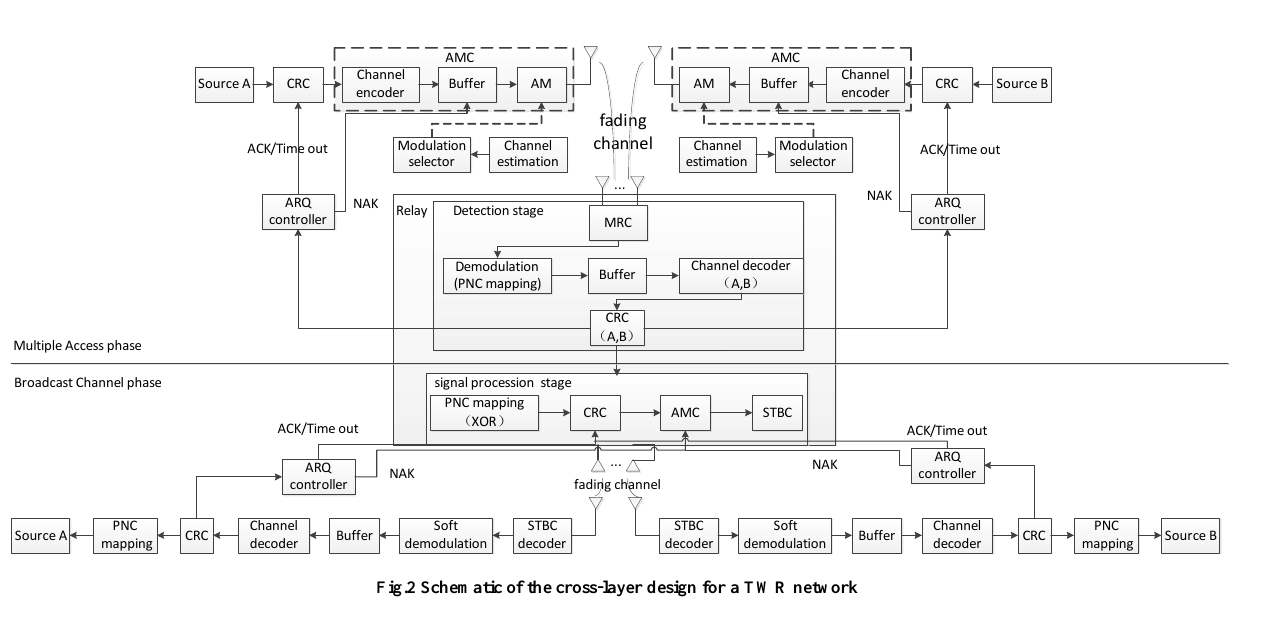
Fig.2 Schematic of the cross-layer design for a TWR